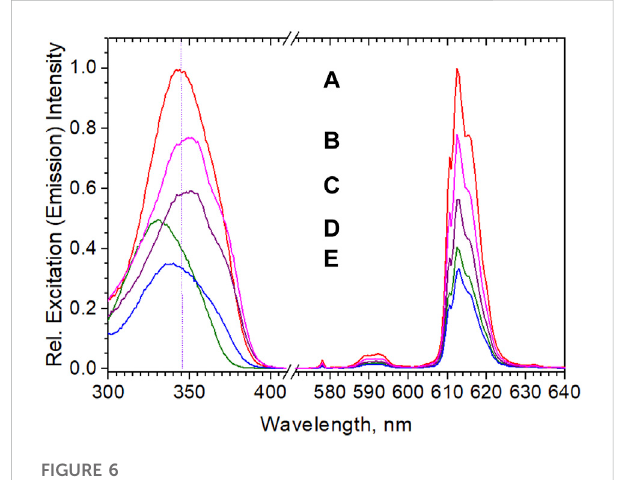
FIGURE 6 Excitation and emission spectra of Eu(diketonate) 3 (TOPO) 2 – beads in 0.001% wt aqueous dispersions, complex fi nal content of beads in brackets: (A) Eu(ttfa) 3 (TOPO) 2 (2.94% wt); (B) Eu(ptfa) 3 (TOPO) 2 ,(1.99% wt); (C) Eu(ptfa) 3 (TOPO) 2 (1.2%wt); (D) Eu(btfa) 3 (TOPO) 2 (2.67%wt); (E) Eu(ntfa) 3 (TOPO) 2 (0.82% wt). Spectra are normalized relative to Eu(ttfa) 3 (TOPO) 2 .